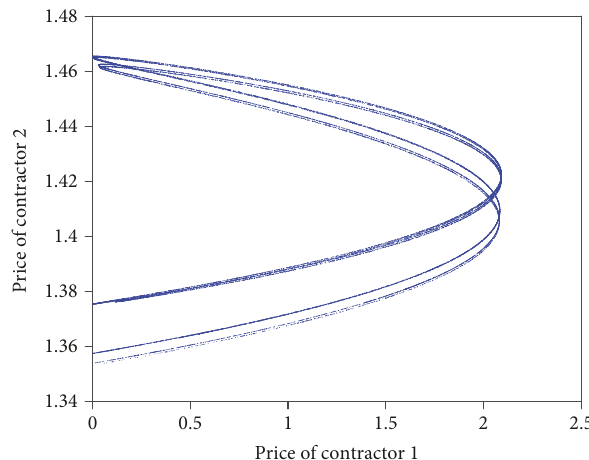
Figure 2: Price strange attractor in situation 1.